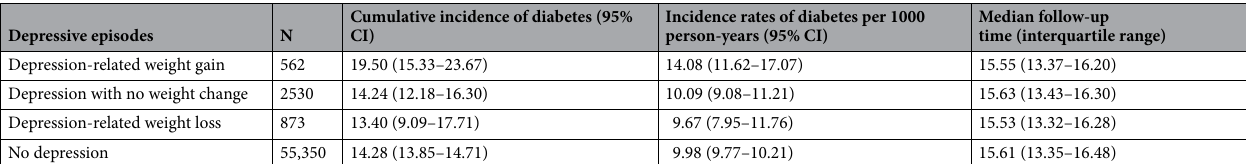
Table 2. Incidence of death, type 2 diabetes, and follow-up time stratified by depression-related weight change for Ontario adults in the NPHS 1996, CCHS Cycle 1.1, CCHS Cycle 2.1 (n = 59,315). Weighted using survey weights provided by Statistics